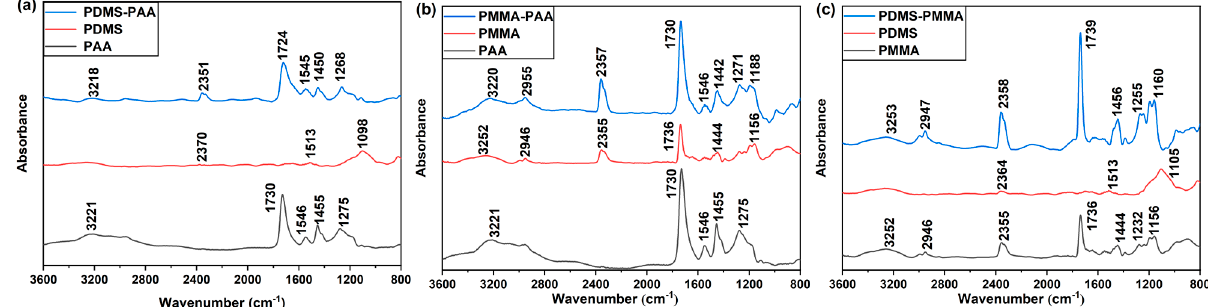
Figure 4. FT-IR spectra in the 800–3600 cm − 1 range of the SERS gas sensor coated by ( a ) PDMS-PAA, ( b ) PMMA-PAA and ( c ) PDMS-PMMA polymer film.